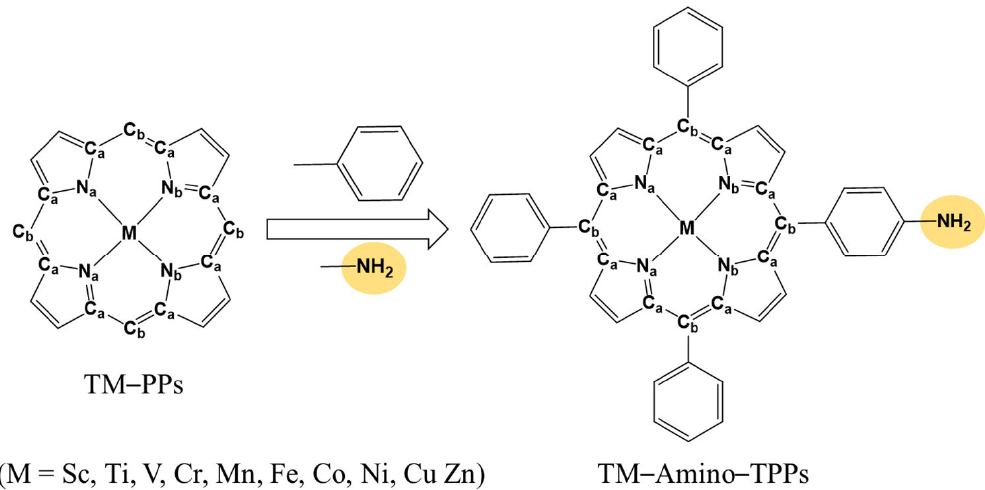
Figure 6. The idea of designing new TM–amino–porphyrin complexes. Table 3. The predicted values of G(H*), G(C*OOH), and G(O*CHO) from Equations (1A)–(3A), re- spectively, for the newly designed transition-metal amino–porphyrin complexes (TM–Amino– TPPs, TM = Sc, Ti, V, Cr, Mn, Fe, Co, Ni, Cu, and Zn). TM–Amino–TPPs